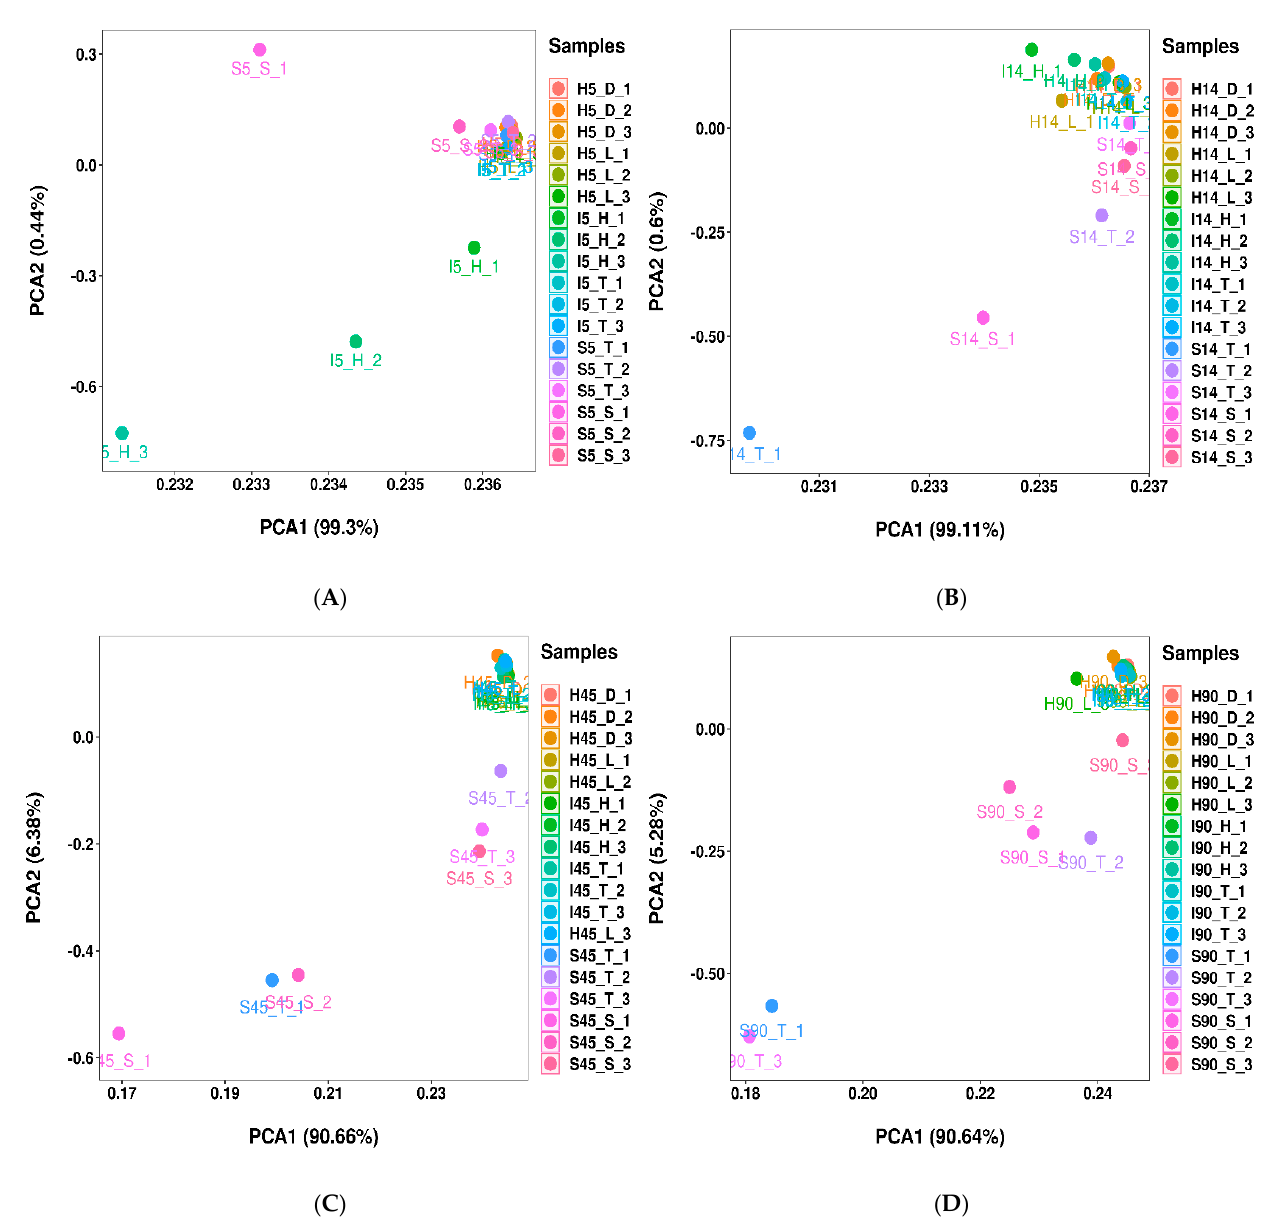
Figure 2. Principal-component analysis of bacterial communities at ( A ) 5, ( B ) 14, ( C ) 45 and ( D ) 90 days after ensiling ( n = 3). Whole-plant corn silages were processed at 6 locations in 3 areas of North China: Heilongjiang province (Daqing city (H_D; 124 ◦ 43 (cid:48) 42.074 (cid:48)(cid:48) E, 46 ◦ 18 (cid:48) 32.083 (cid:48)(cid:48) N) and Longjiang county (H_L; 123 ◦ 7 (cid:48) 32.120 (cid:48)(cid:48) E, 47 ◦ 21 (cid:48) 23.396 (cid:48)(cid:48) N), cold and wet agricultural area), Inner Mongolia Autonomous Region (Helin county (I_H; 111 ◦ 36 (cid:48) 21.625 (cid:48)(cid:48) E, 40 ◦ 28 (cid:48) 47.672 (cid:48)(cid:48) N) and Tumet Left Banner (I_T; 111 ◦ 9 (cid:48) 31.399 (cid:48)(cid:48) E, 40 ◦ 41 (cid:48) 29.832 (cid:48)(cid:48) N), temperate and dry pastoral area) and Shanxi province (Taigu (S_T; 112 ◦ 37 (cid:48) 53.792 (cid:48)(cid:48) E, 37 ◦ 25 (cid:48) 57.230 (cid:48)(cid:48) N) and Shanyin (S_S; 112 ◦ 52 (cid:48) 06.676 (cid:48)(cid:48) E, 39 ◦ 32 (cid:48) 54.503 (cid:48)(cid:48) N) counties, temperate and dry agricultural